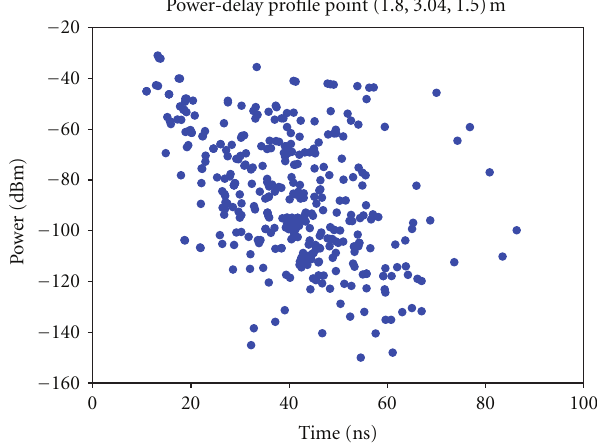
Figure 12: Power-delay profile at point (1.8, 3.04, 1.5)m in the indoor